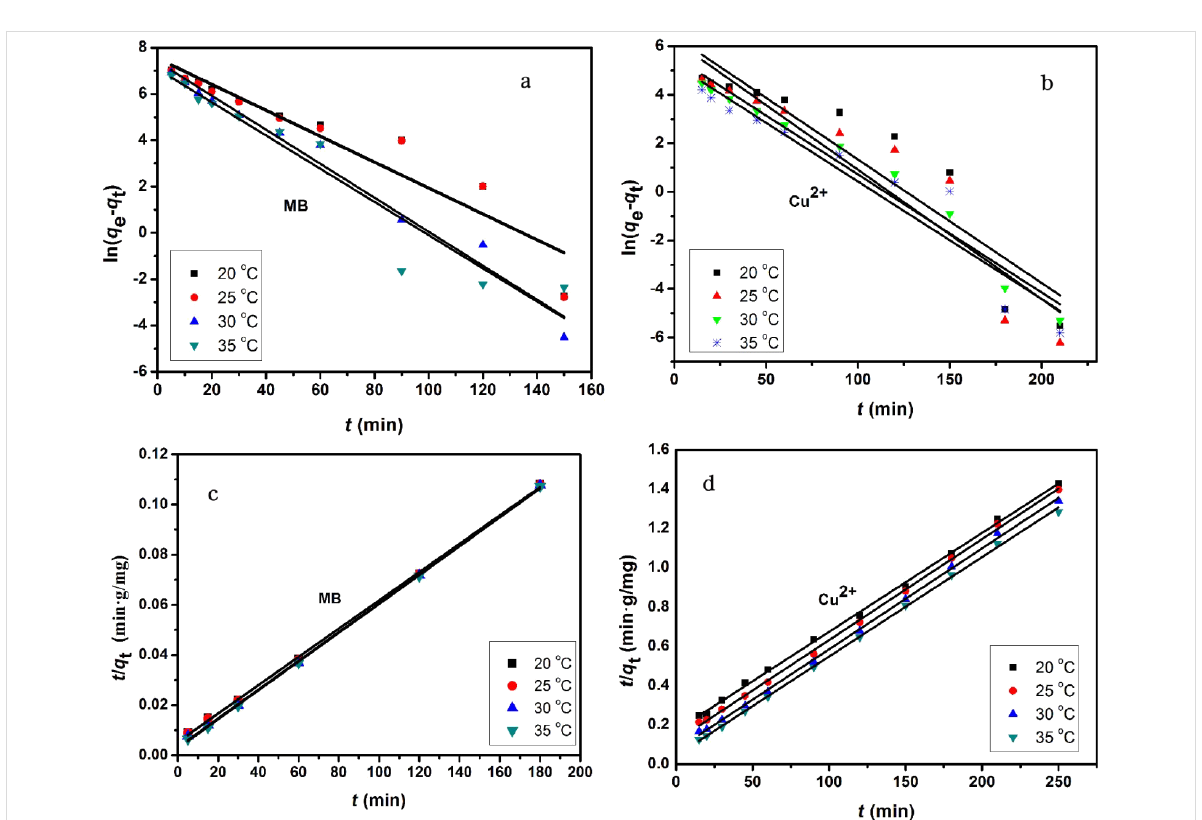
Figure 6: (a,b) Pseudo-first-order and (c,d) pseudo-second-order kinetics models for MB and Cu 2+ adsorption on Lys-GO (initial conditions: MB 1800 mg/L, solution pH 8.0; Cu 2+ 200 mg/L, pH